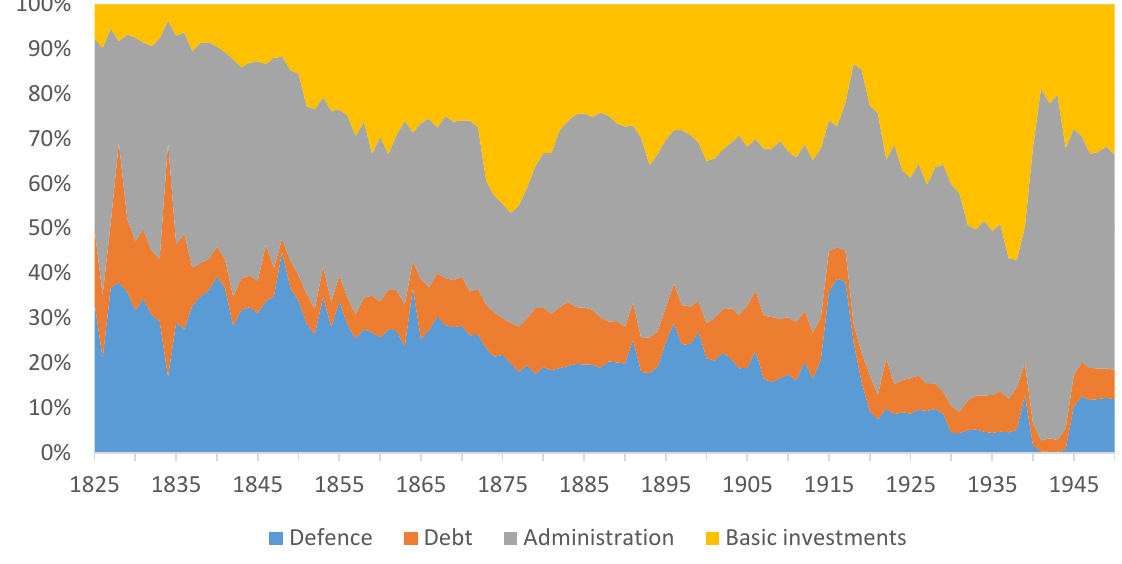
Figure 5. Central government spending by composition as share of total in percent,